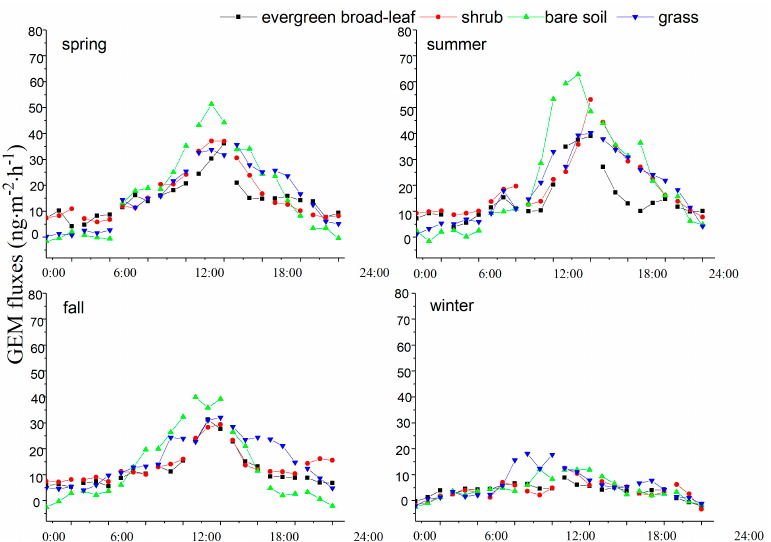
Figure 3. Comparison of daily variation of GEM fluxes in soils under the four vegetation covers in the four seasons . This figure was based on the average data of each season (seven days) for two years.